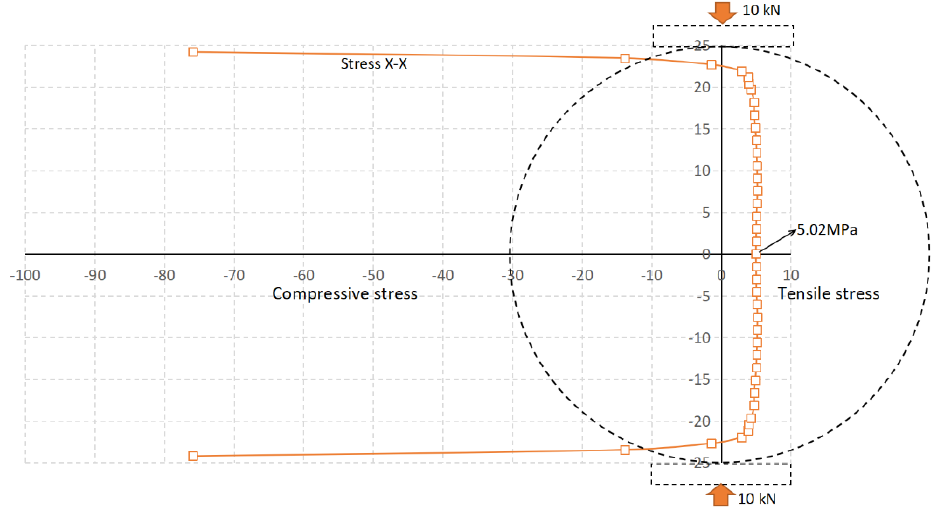
Figure 13. The stress X − X distribution in the monitoring line for Type II testing under external load of 10 kN.